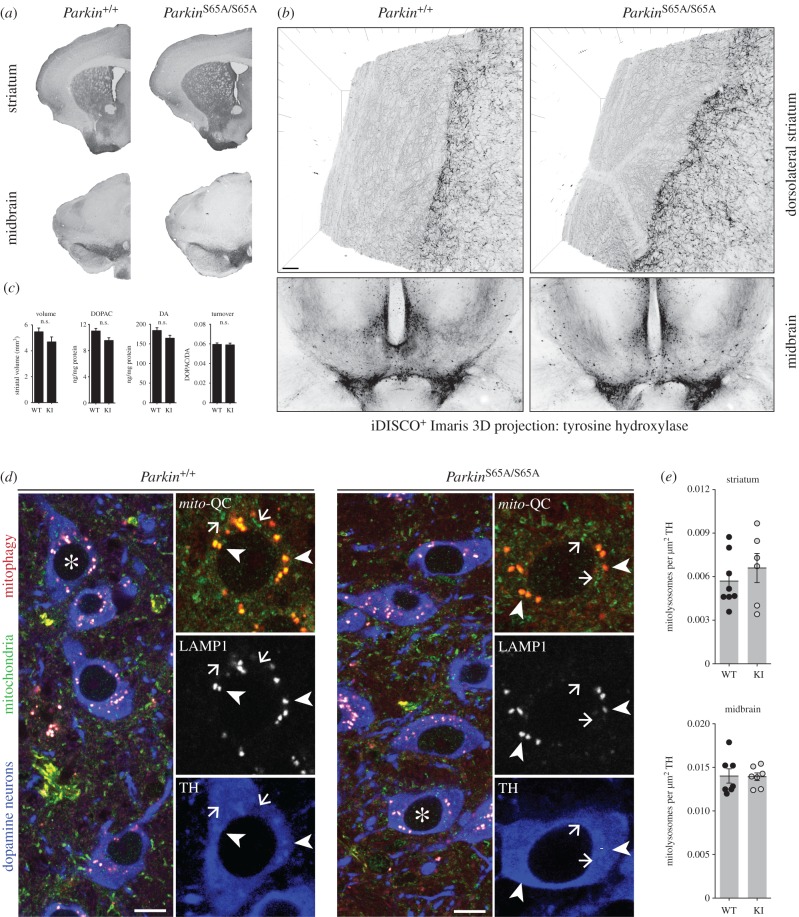
ParkinS65A/S65A mice do not exhibit nigrostriatal degeneration or defective mitophagy. (a–c) Striatal innervation is indistinguishable between wild-type and ParkinS65A/S65A (KI) mice. (a) No differences in neuron number or striatal innervation were observed by anti-tyrosine hydroxylase (TH)-based immunohistochemistry analysis of midbrain and striatum between genotypes. (b) Striatal innervation analysis of TH-positive DA neurons within intact brains processed by iDISCO+. Arborization of DA neurons is indistinguishable between wild-type and KI mice. (c) No differences were observed in striatal volume between genotypes. Error bars represent standard errors of the mean. Striatal dopamine levels are unaltered in ParkinS65A/S65A mice. HPLC analysis revealed no differences in dopamine (DA) and 3,4-dihydroxyphenylacetic acid (3,4-DOPAC) levels between wild-type and KI mice (n = 10 per genotype). Data represent mean values ±s.e.m. n.s., not significant. (d) Basal mitophagy is unaltered by endogenous Parkin activation in vivo. Maximum z-projections of midbrain DA neurons from mito-QC wild-type and KI mice immunolabelled with antibodies to TH (blue) and LAMP1 (greyscale). Arrows point to mitochondria and arrowheads point to mitochondria associated with (autophago)lysosomes/mitolysosomes as defined by co-localization of LAMP1 and mito-QC staining. Mitochondrial delivery to lysosomes (mitophagy) is associated with quenching of GFP signal of the mito-QC reporter and residual mCherry only signal intensity. Scale bar 5 µm. Asterisks indicates cells within insets. (e) Quantitation revealed no differences between mitophagy in DA cell bodies or axons. Results are expressed as mean values ± s.e.m.